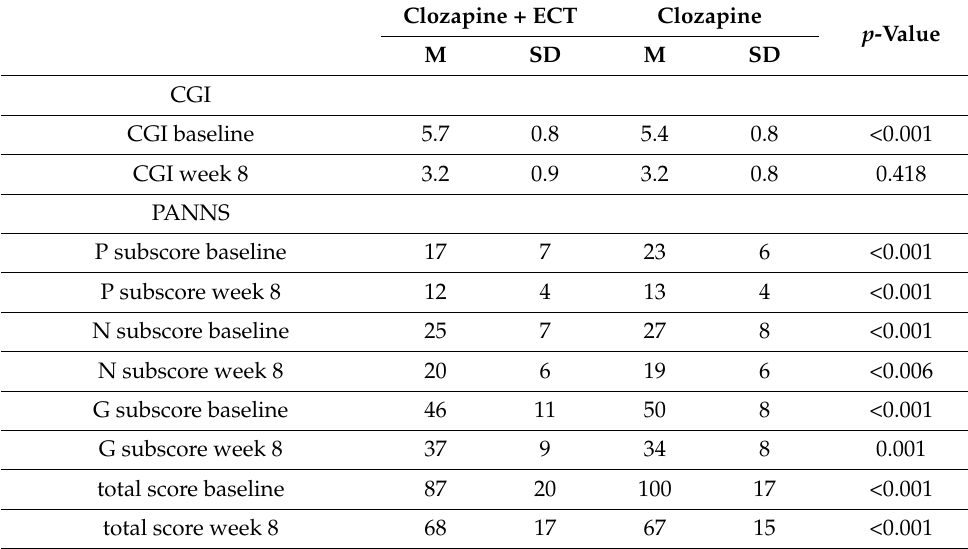
Table 2. Clinical Outcomes of Patients by Treatment